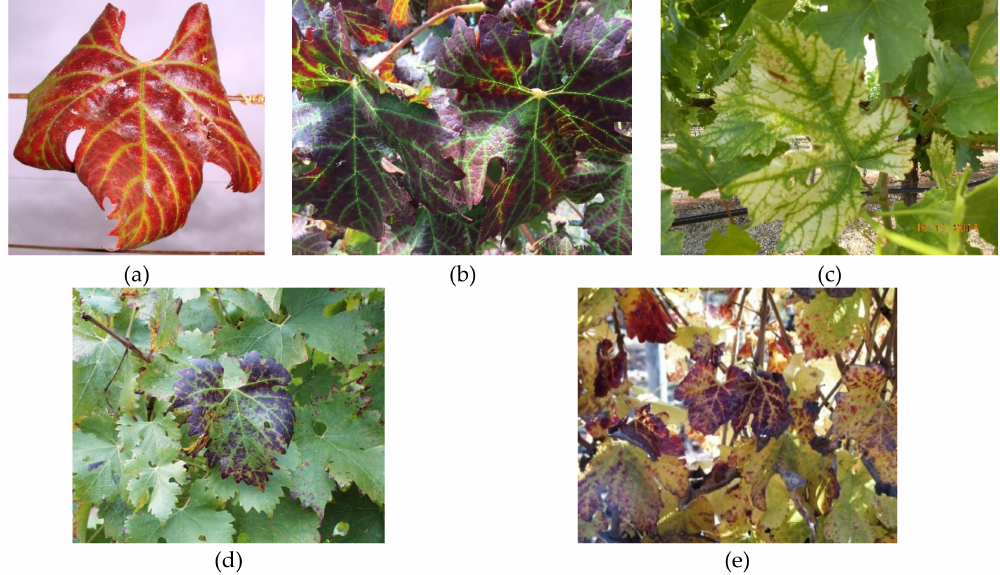
Figure 2. Symptomatology of grapevine leafroll disease. ( a ) leaf margins curled downwards towards the abaxial side of the leaf; ( b ) interveinal regions of leaf blades appear dark red or purple in colour with distinct green veins; ( c ) leaves of white cultivars sometimes appear slightly chlorotic, and the veins may remain green; ( d ) GLRaV-4 strain 9 symptoms on Cabernet Sauvignon; ( e ) GLRaV-4 strain 9 symptoms on